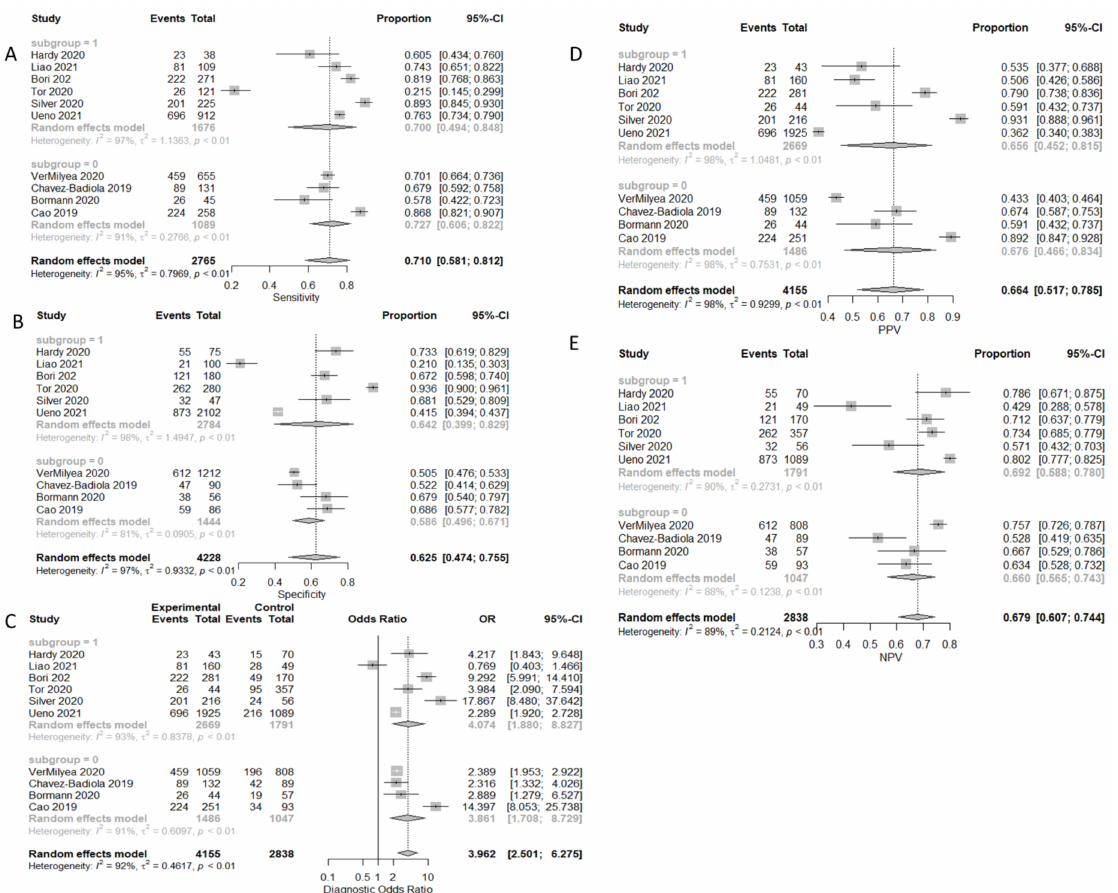
Figure 4. Forest plots representing: ( A ) sensitivity; ( B ) specificity; ( C ) DOR; ( D ) PPV; ( E ) NPV of the clinical pregnancy prediction outcome. Subgroup “0” represents static images as type of input, and subgroup “1” represents time-lapse.